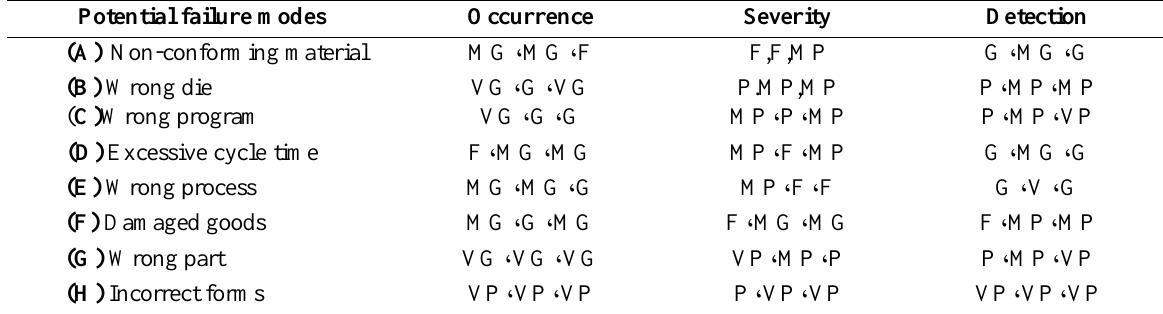
Table 6. Fuzzy experts' evaluations of risk factors associated with the potential failure modes